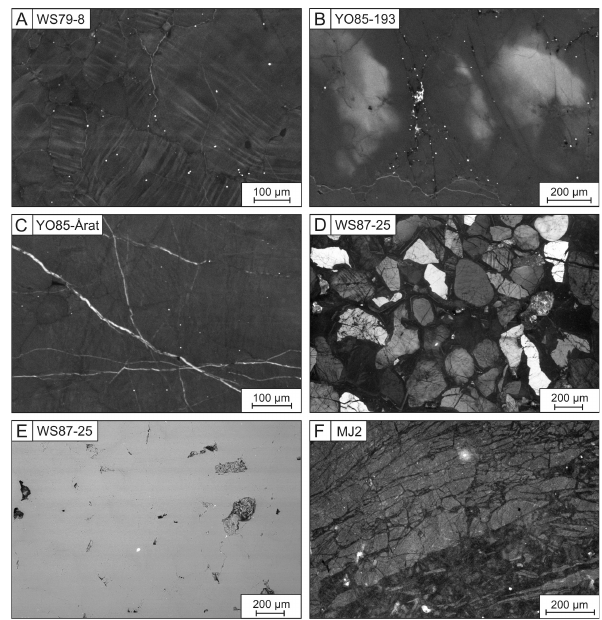
Fig. 8. SEM-CL and SEM images of quartz in onshore samples from Spitsbergen. (A) Distinctive lamella-like CL structures in quartz of the Proterozoic metagranite from Vestkysten. (B) Cloudy, bright luminescent domains in quartz with generally dull CL. Meso- proterozoic quartzite. (C) SEM-CL image of quartz with moderate CL intensity crosscut by thin (<5µm), healed micro-fractures with bright CL. (D) SEM-CL image of Permo-Carboniferous sandstone from the St. Jonsfjord. The majority of grains have bright CL and are overgrown by dull luminescent authigenic quartz. (E) BSE im- age of the same sample domain as shown in (D) illustrating that the interstitial areas of dark CL represent authigenic quartz. (F) SEM- CL image of chert from the Permo-Carboniferous Gipsdalen Group at Billefjord. Fragments of moderate bright luminescent chert are healed by a silica generation with dull